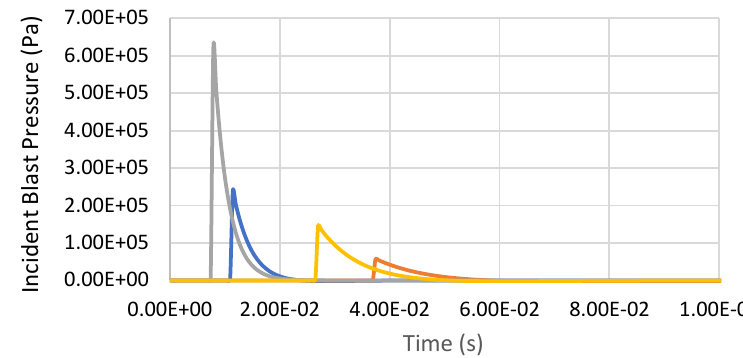
Figure 8. Incident blast pressure versus time graph of all blast cases.